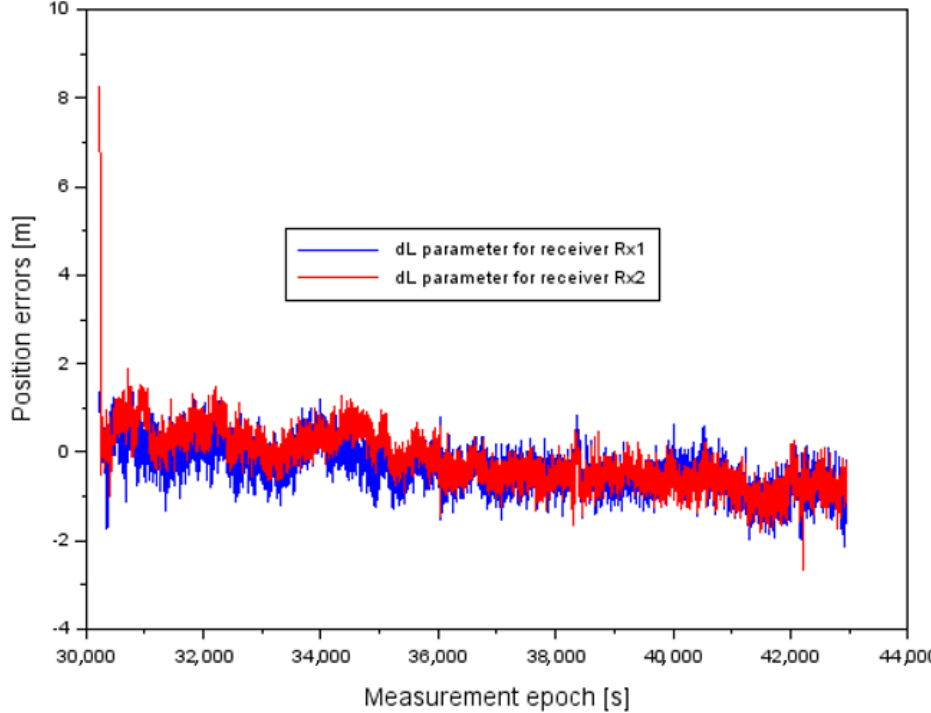
Figure 10. The results of 𝑑𝐿 position errors for 𝑅𝑥1 and 𝑅𝑥2 receivers.